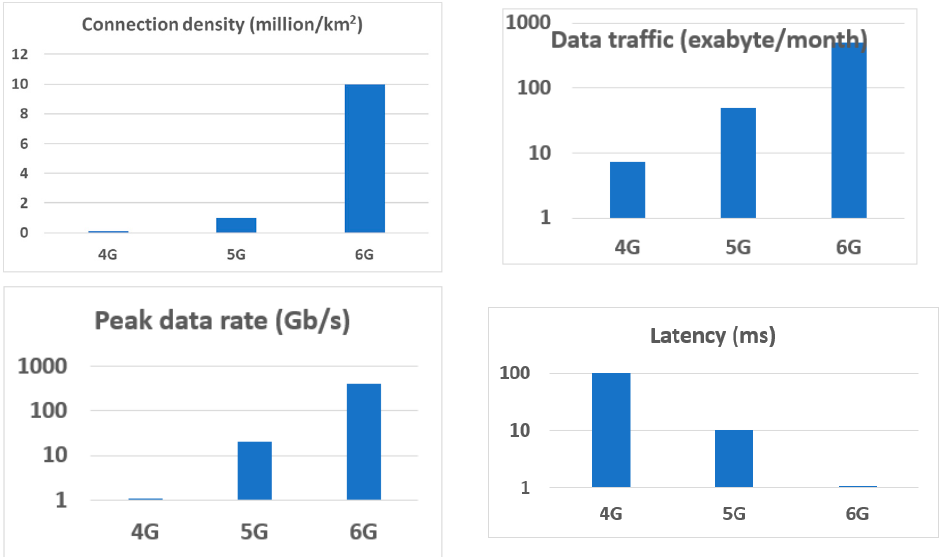
Figure 1. Communication evolution from 4G to 6G.